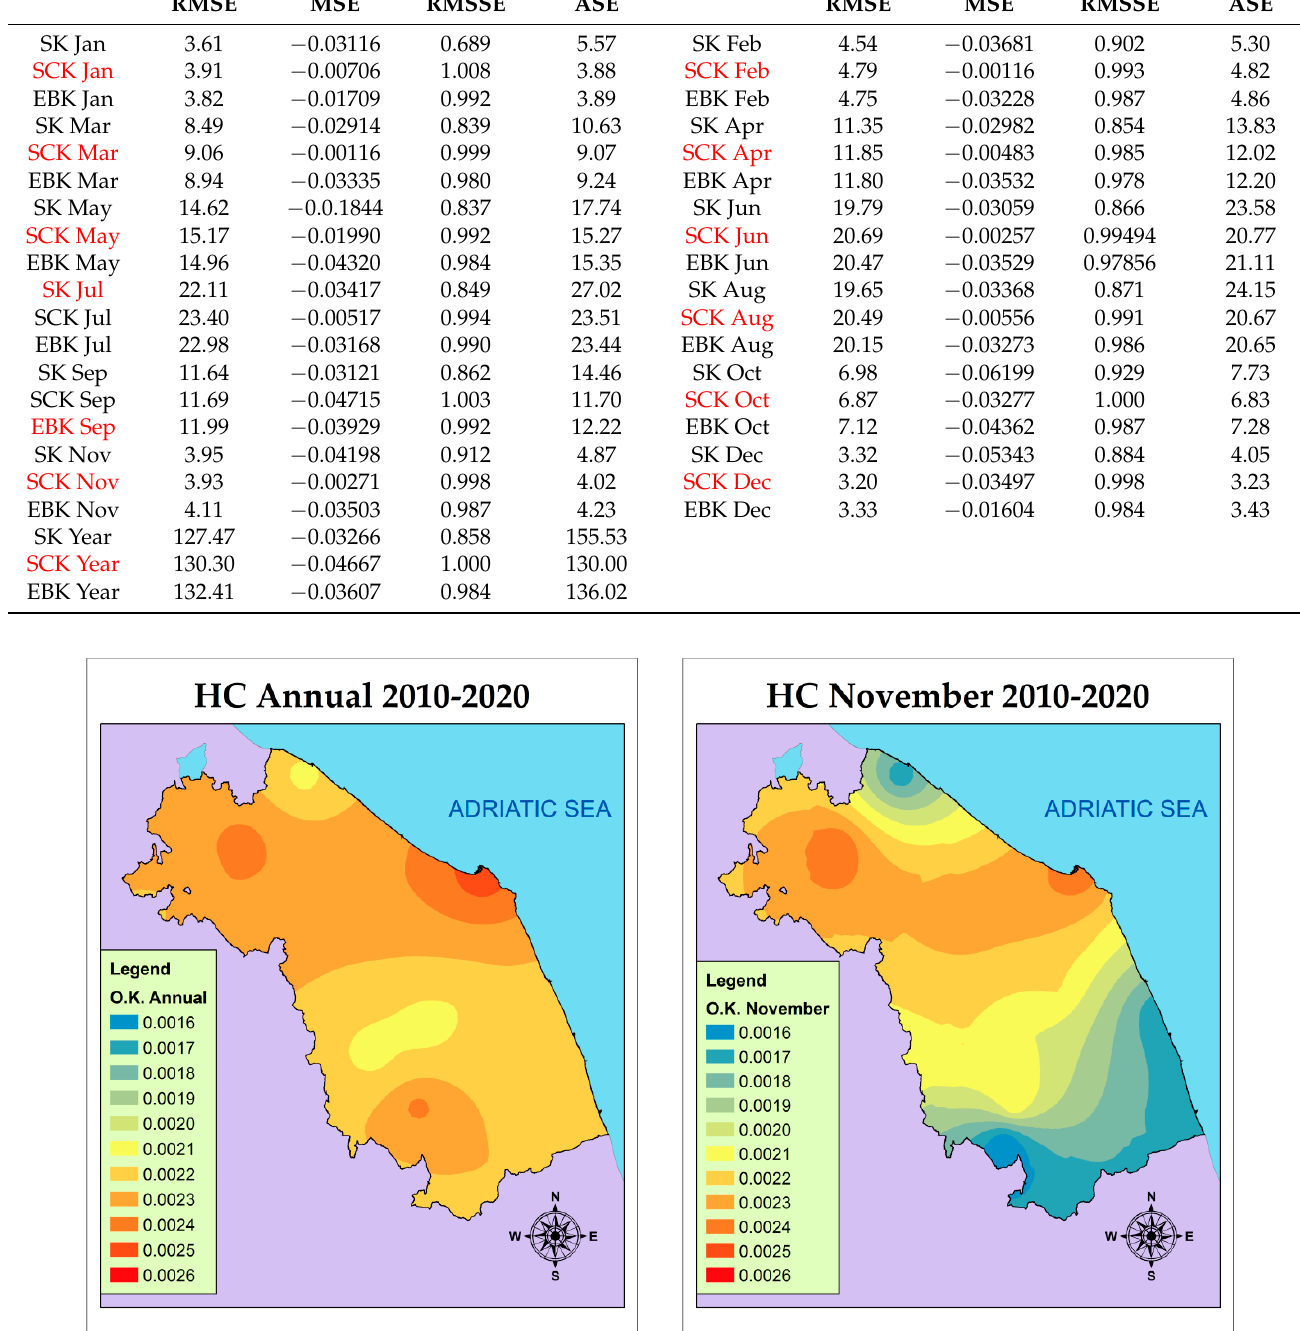
widely obtained in the north and in the coastal sector to the east.